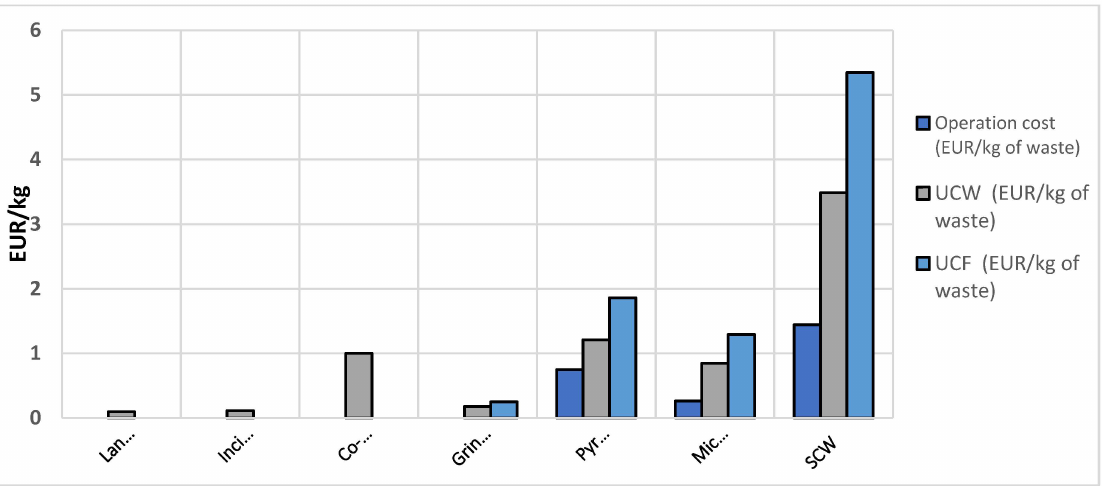
Figure 7. Key: UCW = unit cost per mass of unit waste; UCF = unit cost per mass of recovered fiber; SCW = super critical water. Economic indicators for assessed routes [58], with permission from Elsevier, 2022.